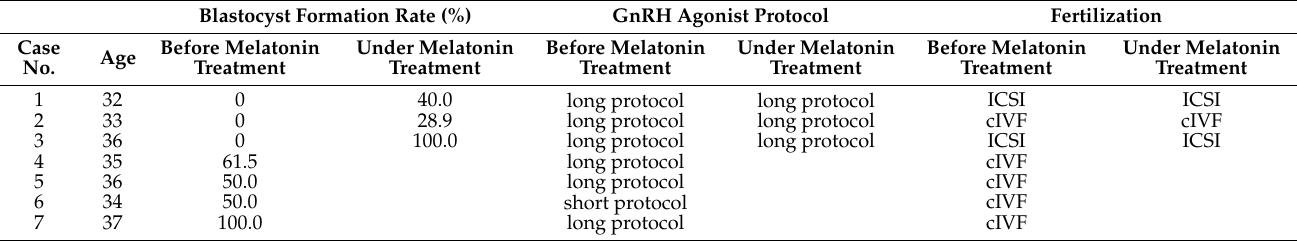
Table 2. Information on cases provided for transcriptome